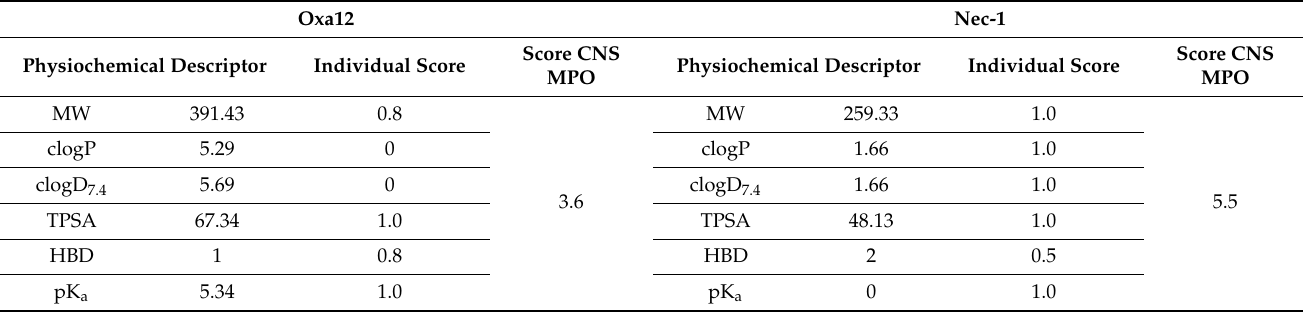
Table 1. Central nervous system MPO calculations for Oxa12 and